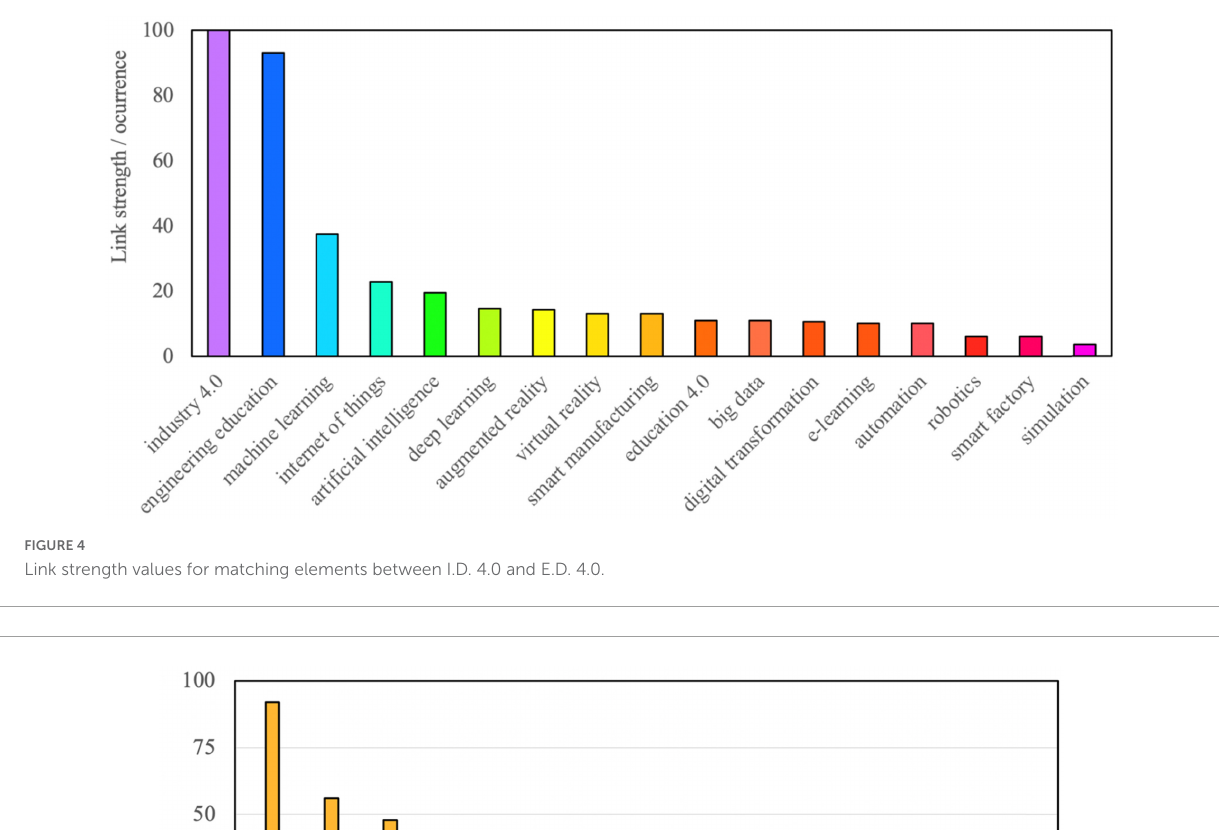
FIGURE4 Link strength values for matching elements between I.D. 4.0 and E.D. 4.0.